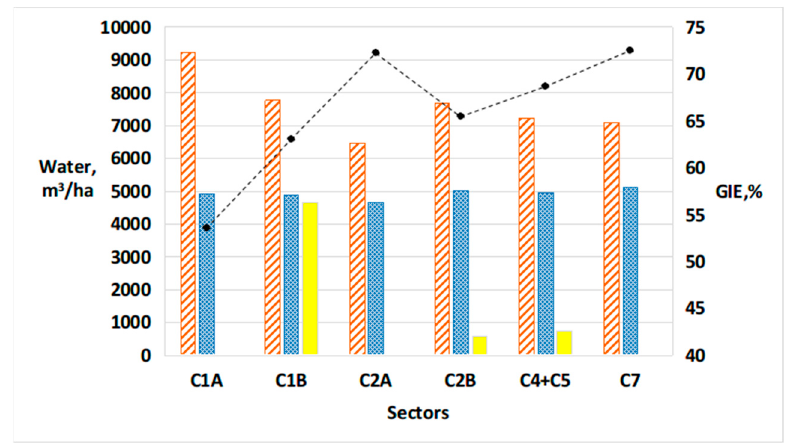
Figure 6. Total Irrigation Affluence (TIA) ( ), Net Irrigation Demand (NID) ( ), and Pumping Irrigation Allocation (PIA) ( ) in m 3 /ha; Global Irrigation Efficiency (GIE, %) ( ); seasonal values per Sector, in 2018.